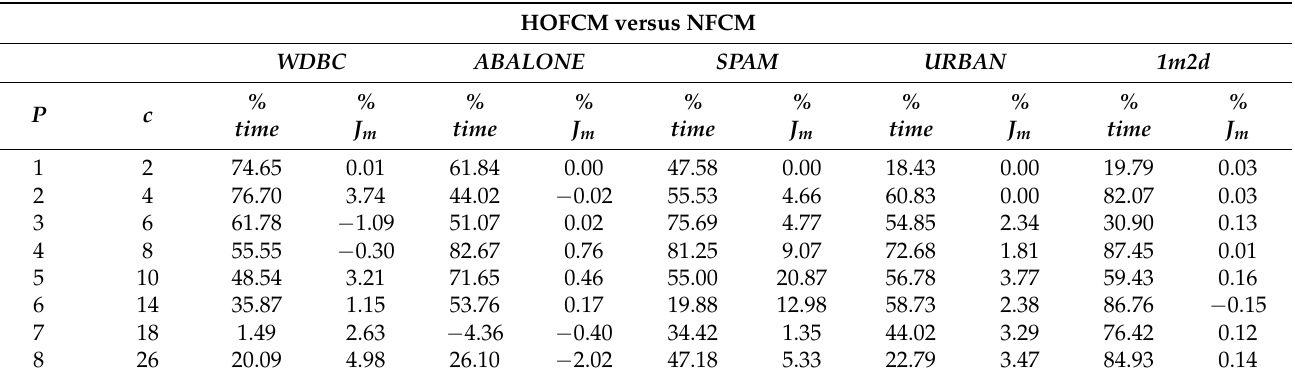
Table 5. Average percentages of time reduction and value of the objective function in Experiment II; HOFCM versus NFCM.